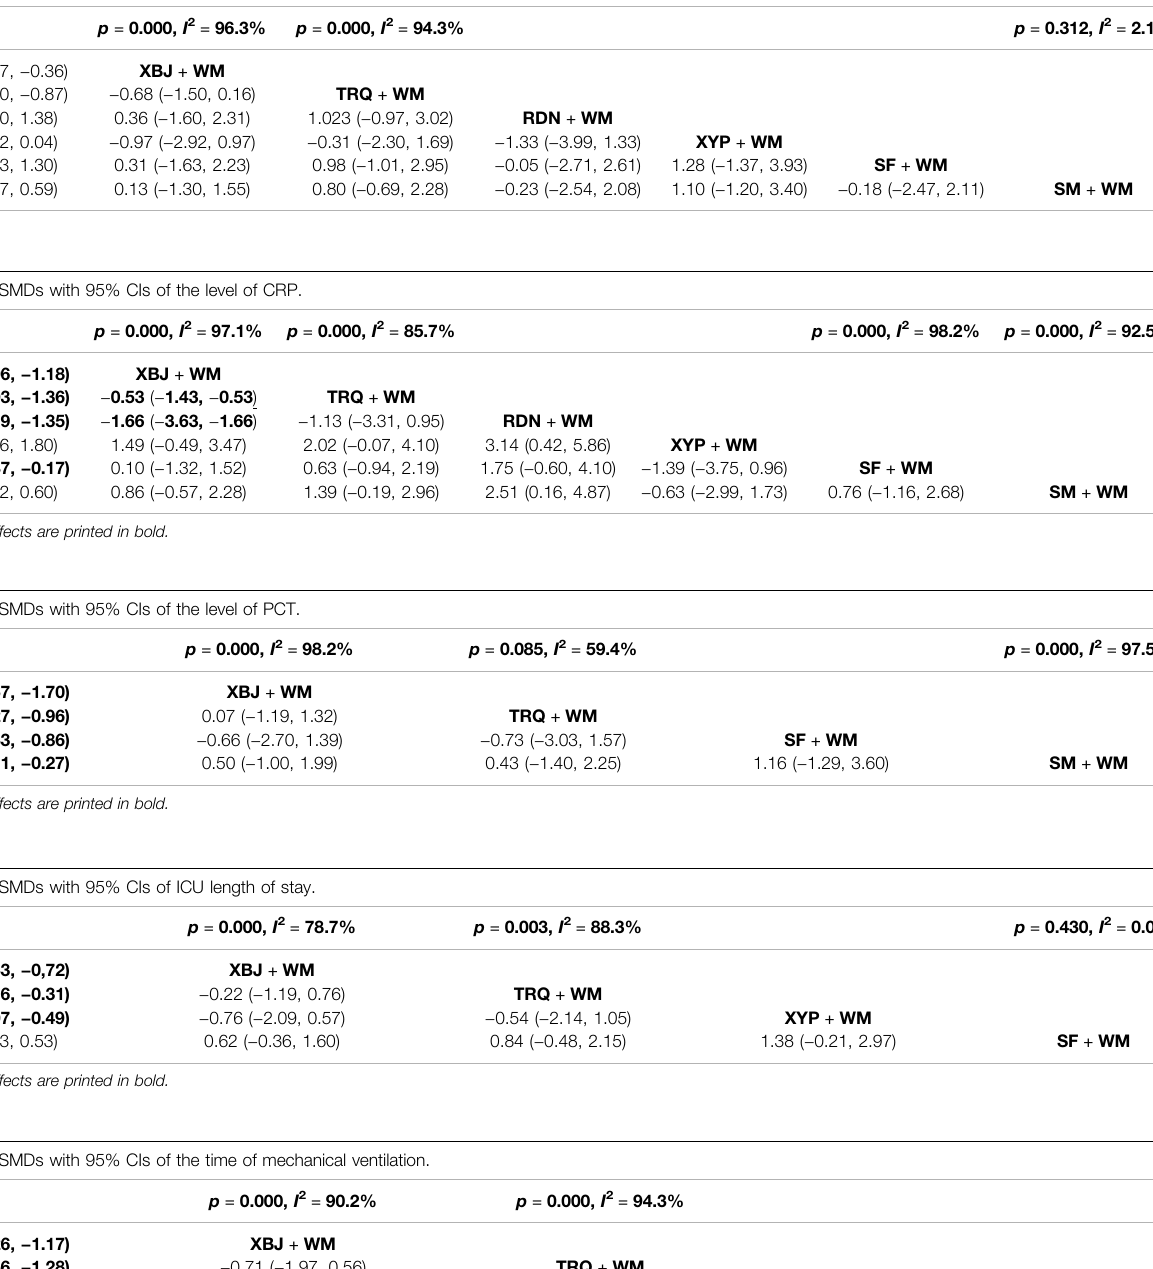
TABLE 3 | SMDs with 95% CIs of the level of WBC.